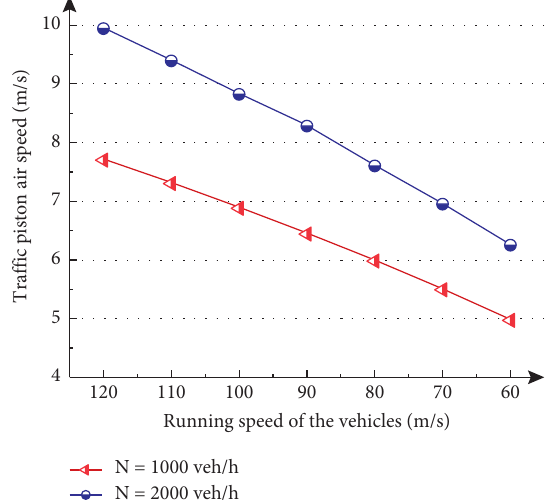
Figure 4: The speed of the traffic piston under different operating conditions.